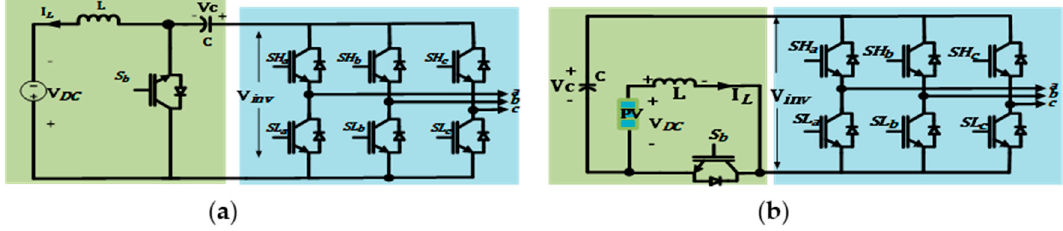
Figure 1. ´Cuk-derived buck-boost inverter; ( a ) the circuit of [25], ( b ) re-arranged ´Cuk-derived Figure 1. Ć uk-derived buck-boost inverter; ( a ) the circuit of [25], ( b ) re-arranged Ć uk-derived buck- buck-boost boost inverter.